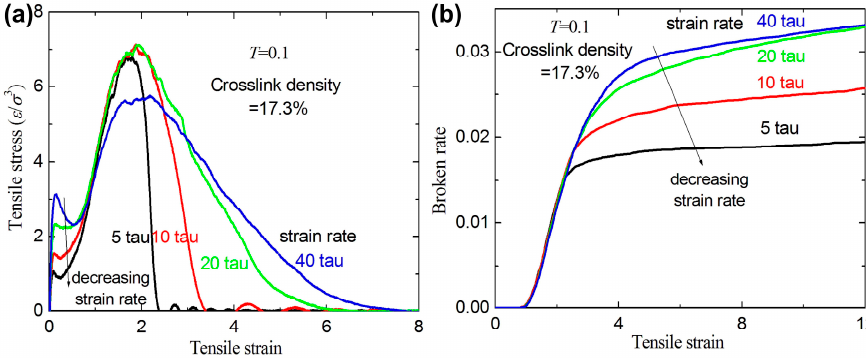
Figure 6. ( a ) The tensile stress ‐ strain curves with different strain rates for a given crosslink density of 17.3%; and ( b ) the broken ratio versus strain rate.